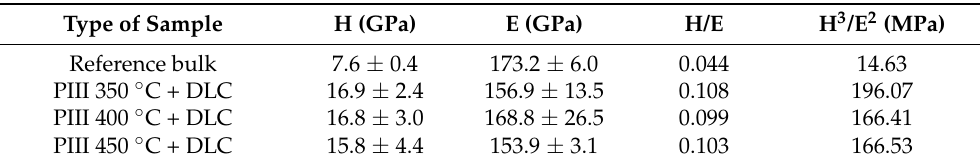
their H/E and H 3 /E 2